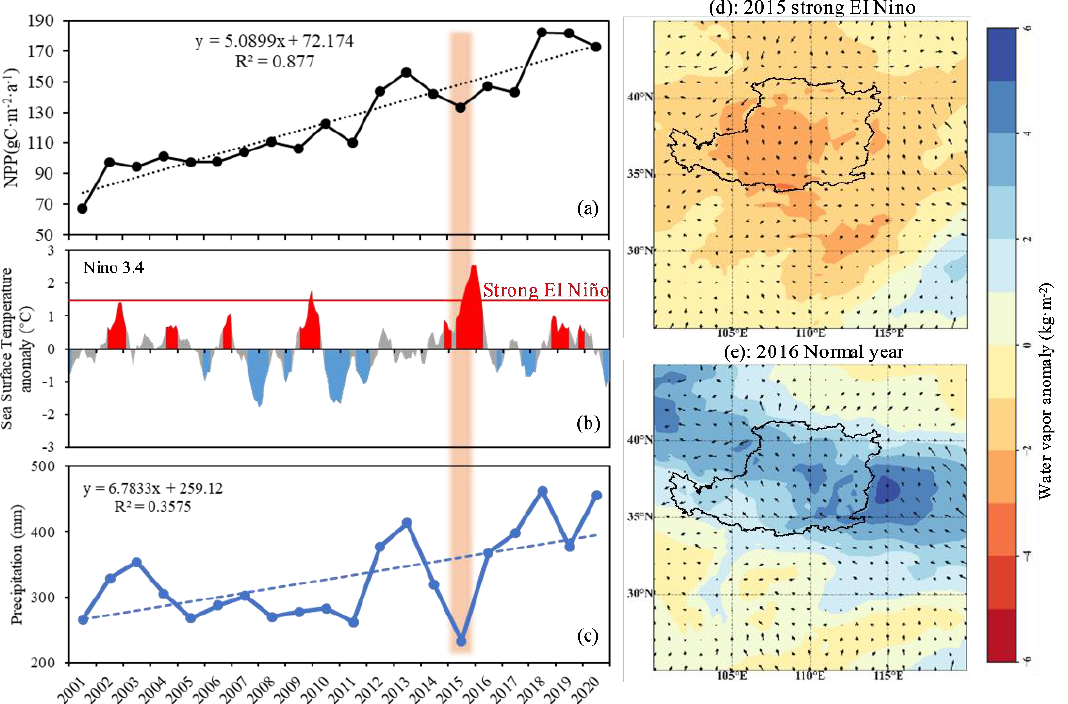
Figure 9. Time series of ( a ) NPP, ( b ) SSTa for Niño 3.4, and ( c ) precipitation in growing season over the periods 2001 – 2020 and anomaly distribution of vertically integrated summer water vapor in ( d ) 2015 and ( e ) 2016. The brown bar represents the decrease in NPP and precipitation affected by the strong El Niño event in 2015. The arrows in panel ( c ) and ( d ) represent the wind direction.